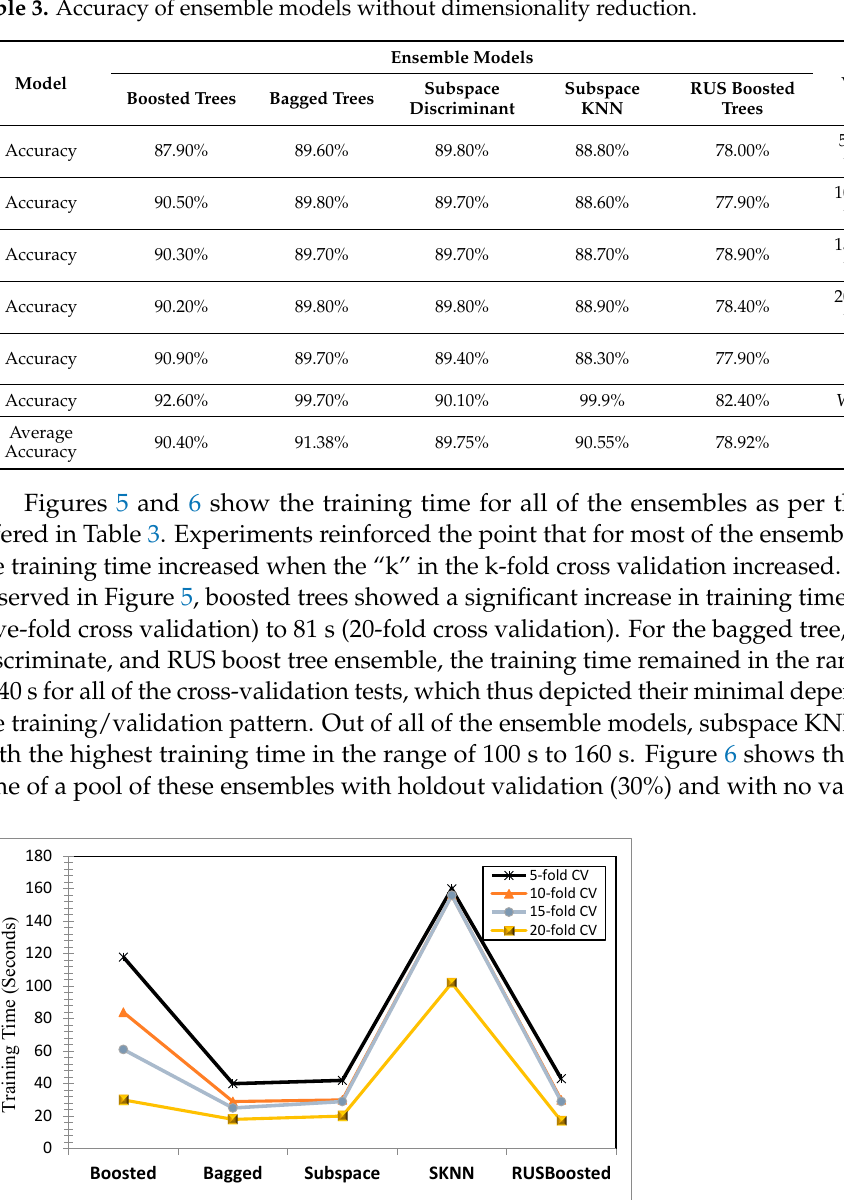
Figure 6. Training time comparison for various ensemble models on holdout method and with no 370 cross-validation .